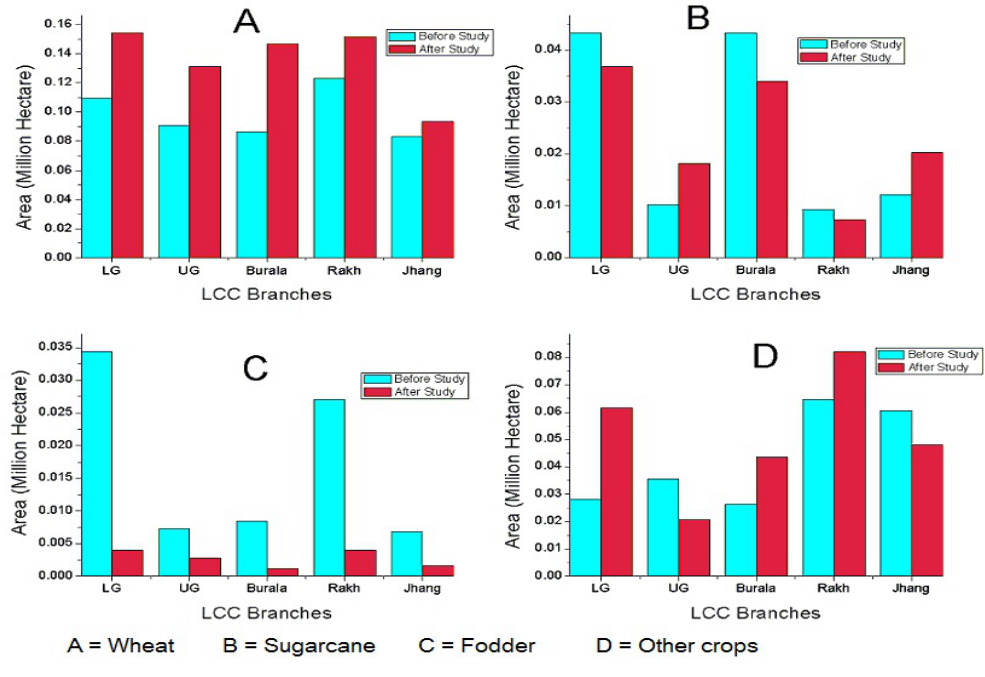
Figure 5. Rabi crops acreage on branches of LCC.